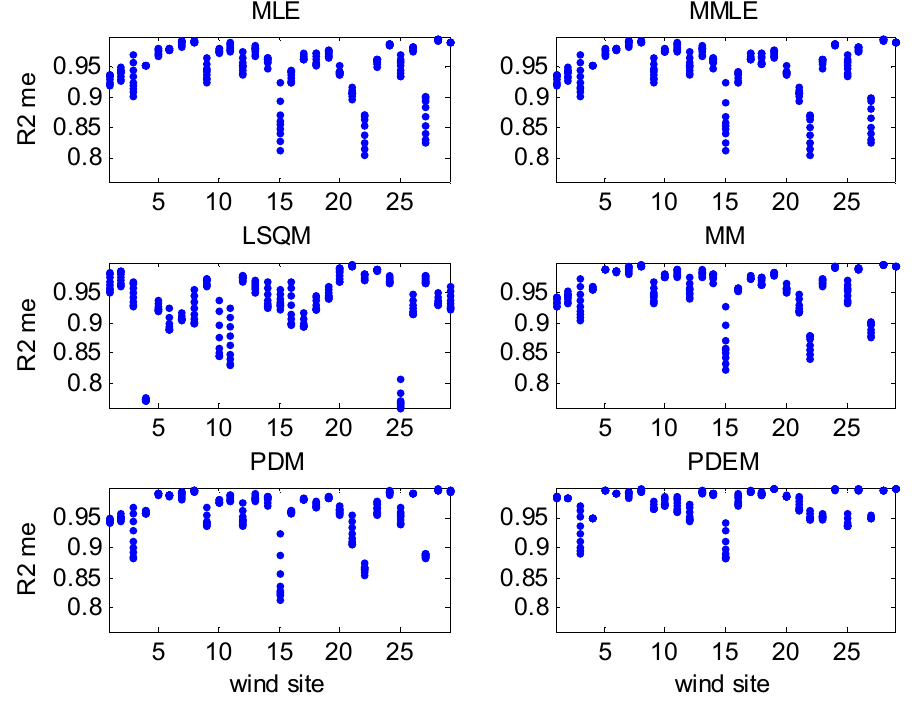
Figure 16. Representation of each component of 2 different wind sites. For each wind site, the final value is the mean value of all the